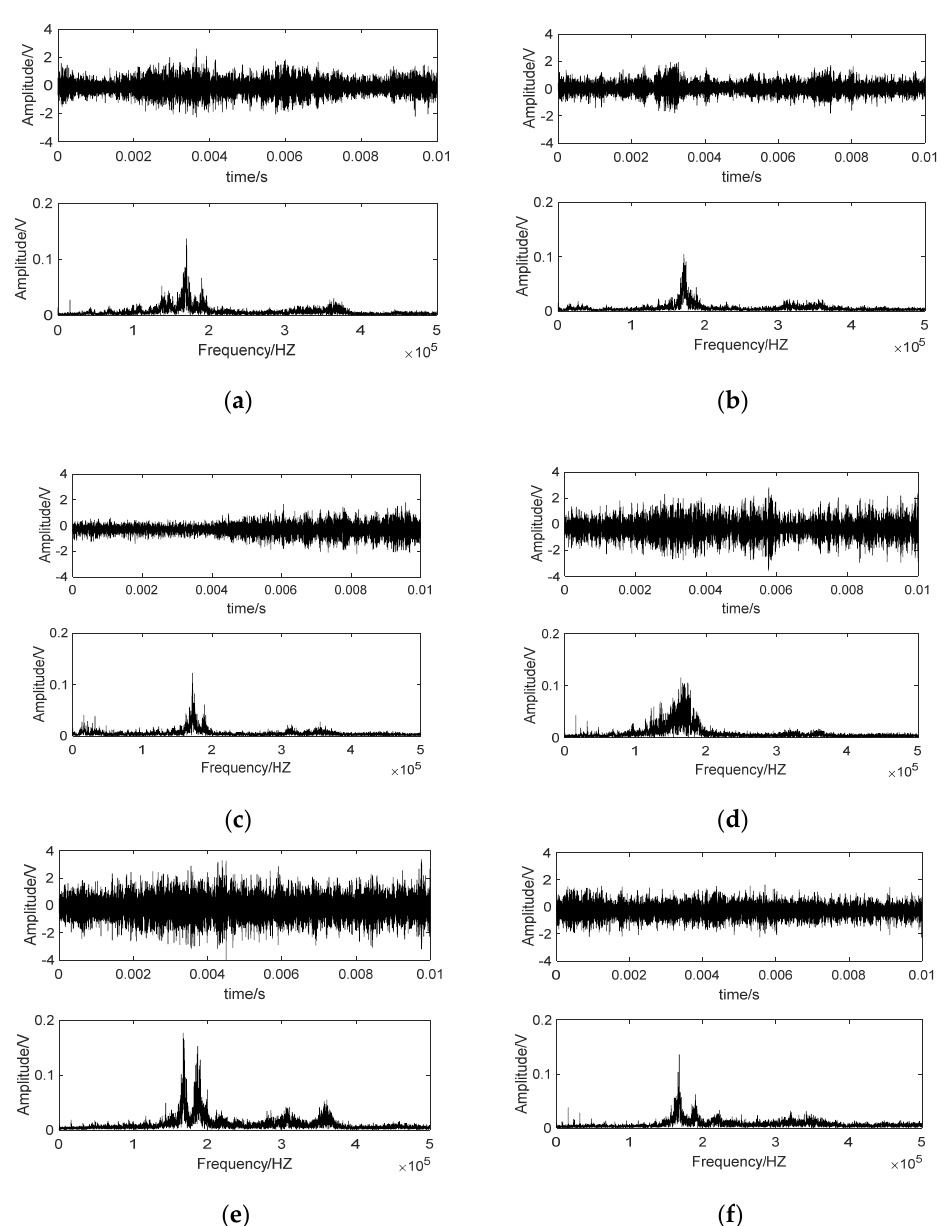
Figure 3. AE signals on different nodes. ( a ) the 1st node; ( b ) the 3rd node; ( c ) the 5th node; ( d ) the 13th node; ( e ) the 17th node; ( f ) the 19th node